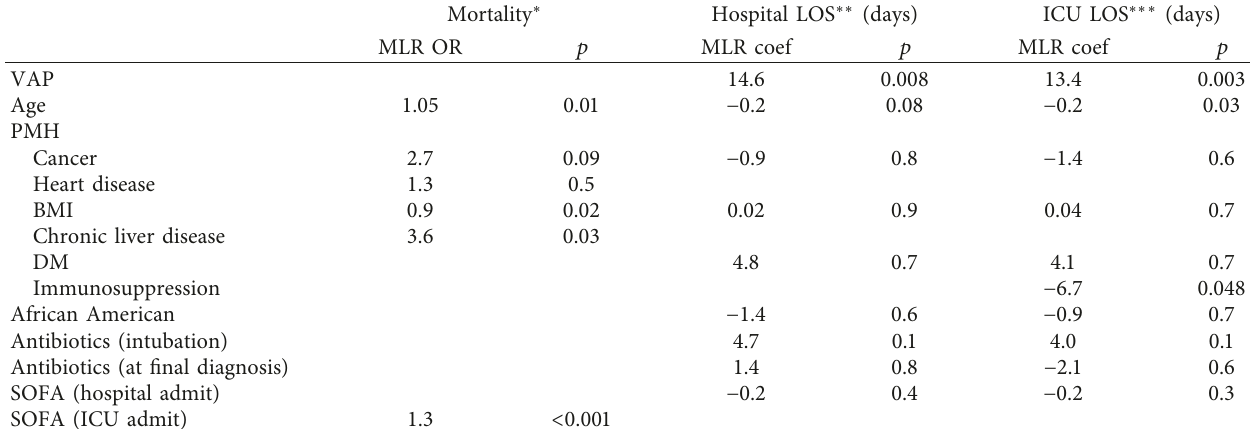
Table 2: Multivariate (MLR) regression analyses for factors associated with VAP.